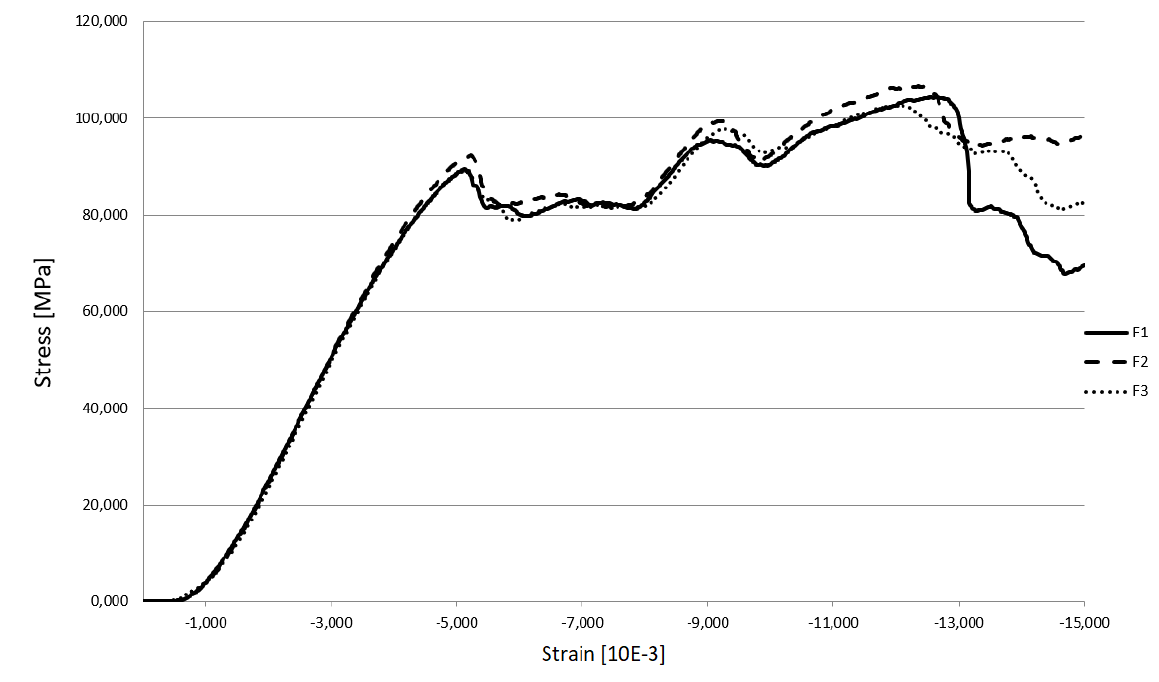
. Figure 4. Stress-strain curves obtained from the compression test. Curves shown belong to the F specimen group. Note the method used to determine global E described in Fig. 5.